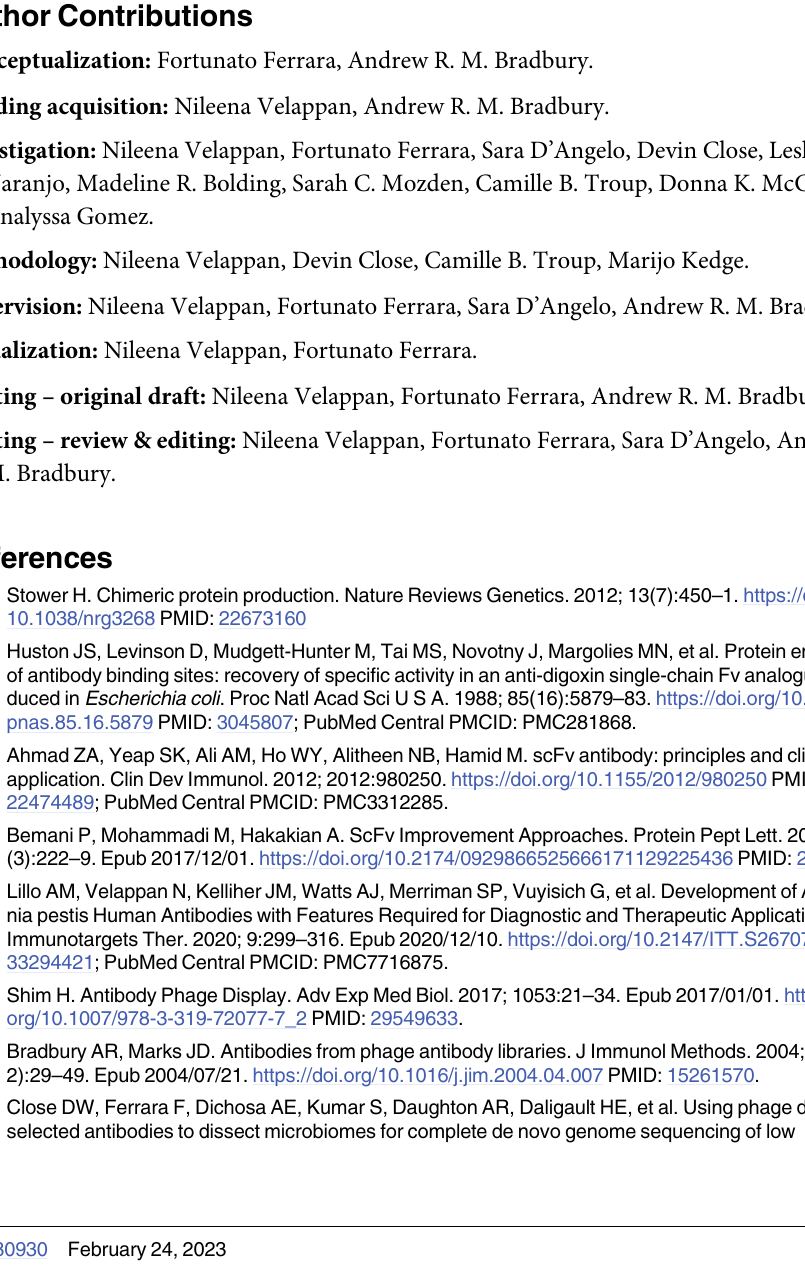
S1 Fig. Chromatograms. The chromatograms obtained for the four scTGPs are shown in comparison to the molecular weight marker. S1 Table. DNA and amino acid sequences of the clones expressed and purified as scFvs and